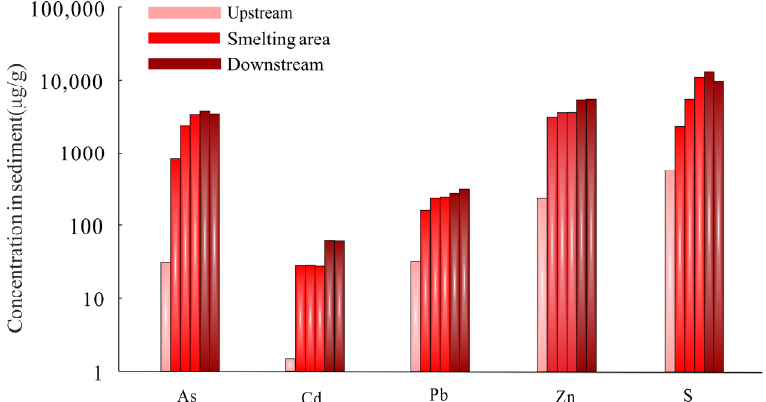
Figure 6. Migration characteristics of different elements in stream sediment. Logarithmic coordinates. The color from light to dark indicates the concentration characteristics of heavy metals in the upstream, midstream, and downstream in order.